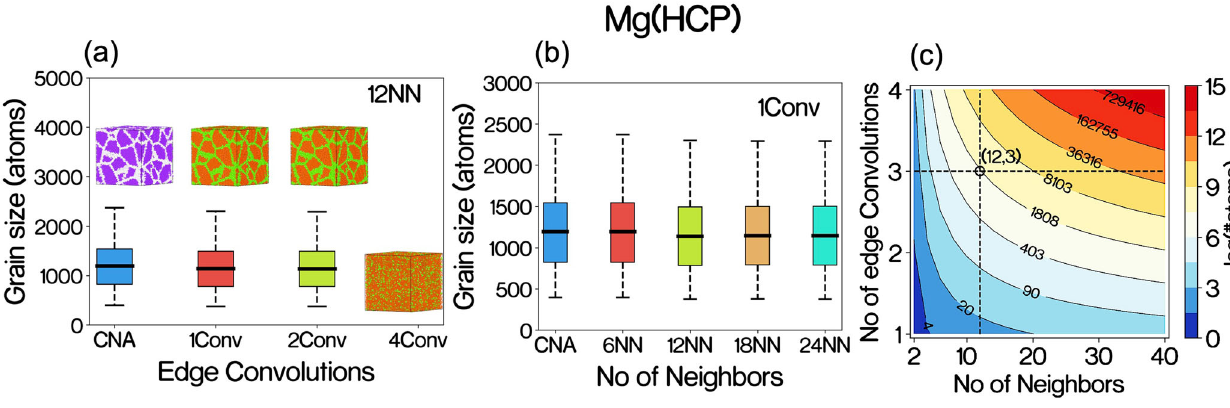
Fig. 6 Effect of model parameters on the predicted grain size distribution. a Effect number of edge-convolutional layer on the prediction of grain size distribution. b Effect of number nearest neighbors used for graph construction on grain boundary prediction. c The amount of information (in terms of the number of atoms) being compressed in a node of the graph for different edge convolutions (& n-1 angle convolutions) and the number of neighbors used for the graph construction.